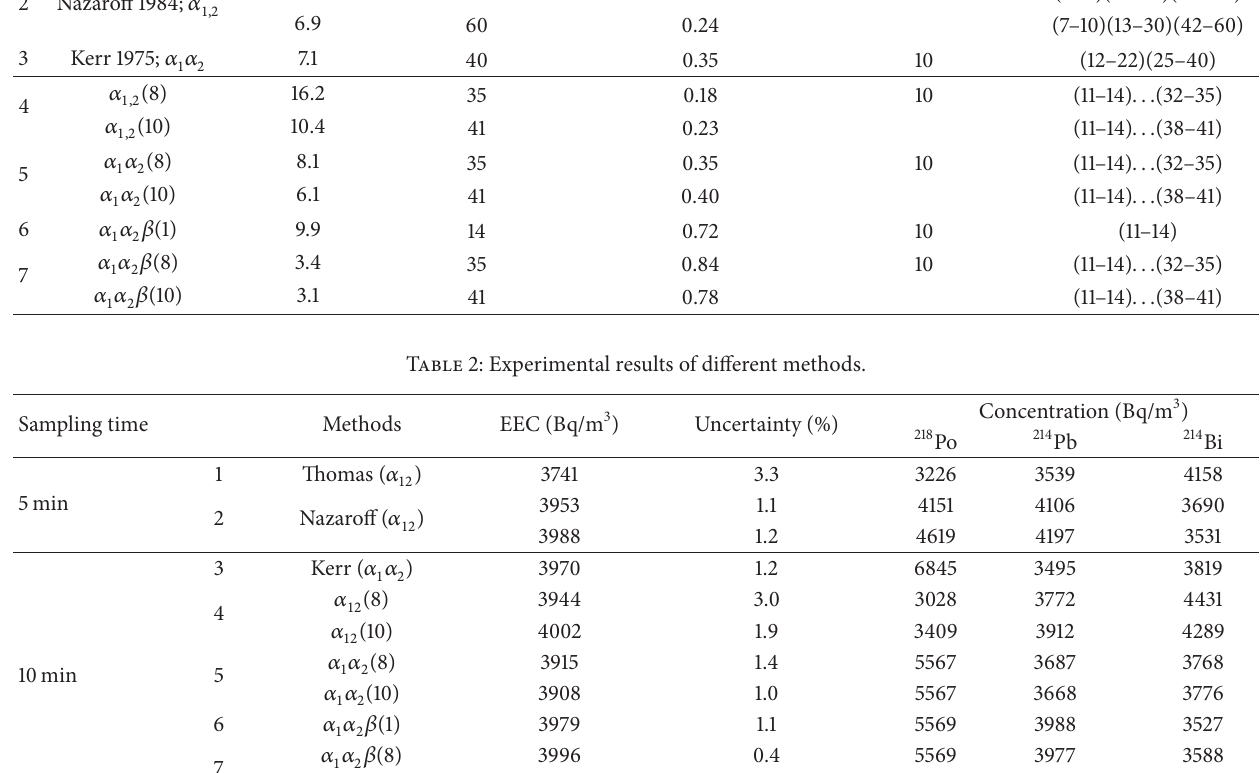
Table 1. Through resolved or numerical calculation, radon progeny’s concentrations are obtained. However, most of time we care more about 218 Po concentration and Equilibrium Equivalent Concentration (EEC) than each radon progeny’s concentrations. The result of radon progeny concentration is shown in Table